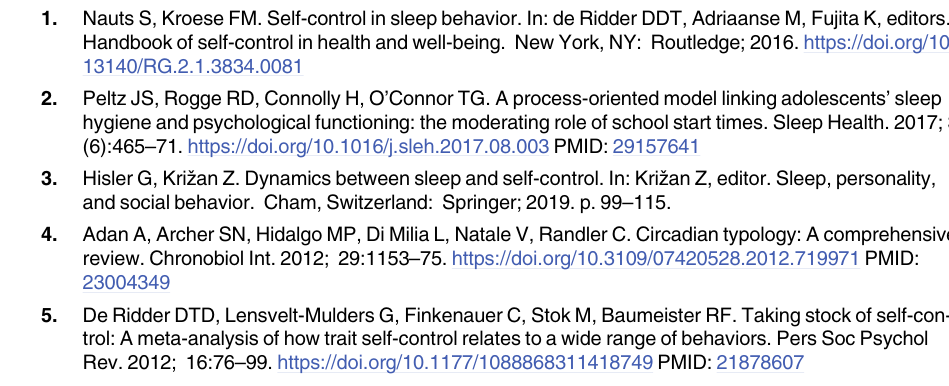
S1 Table. Results from moderated mediation